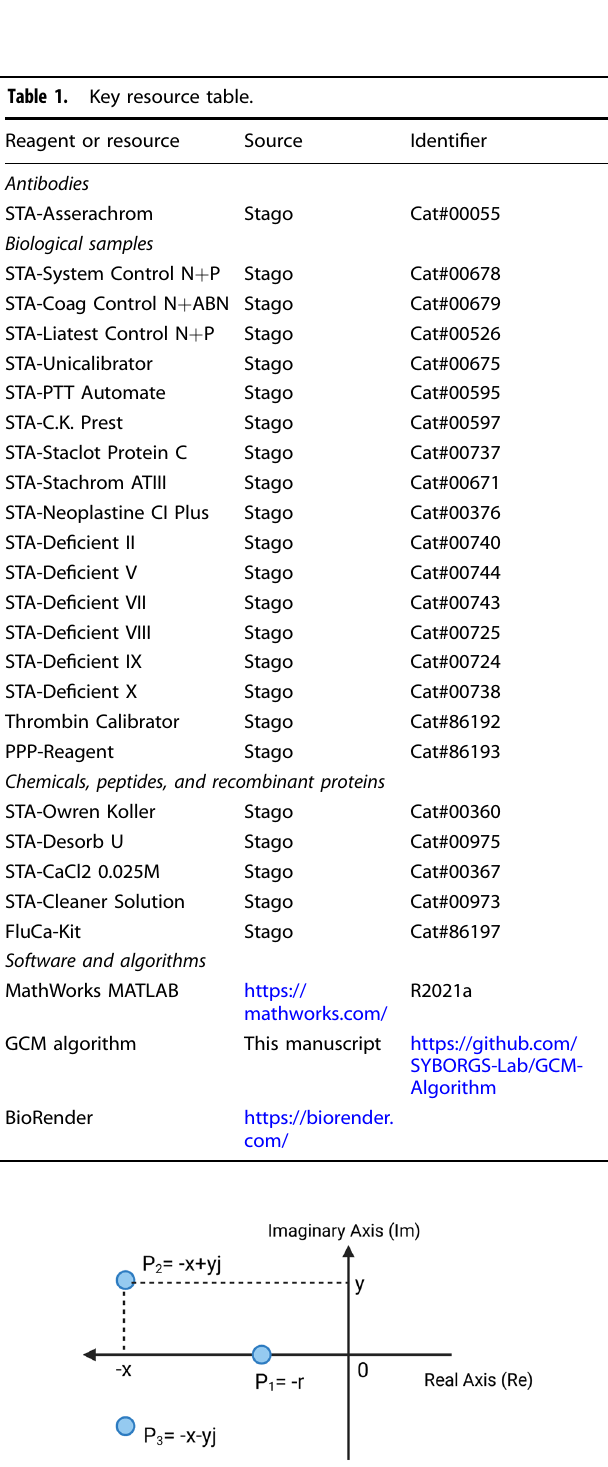
Fig. 10 Dynamical system poles. Three pole orientation of coagulation model (1) in the complex